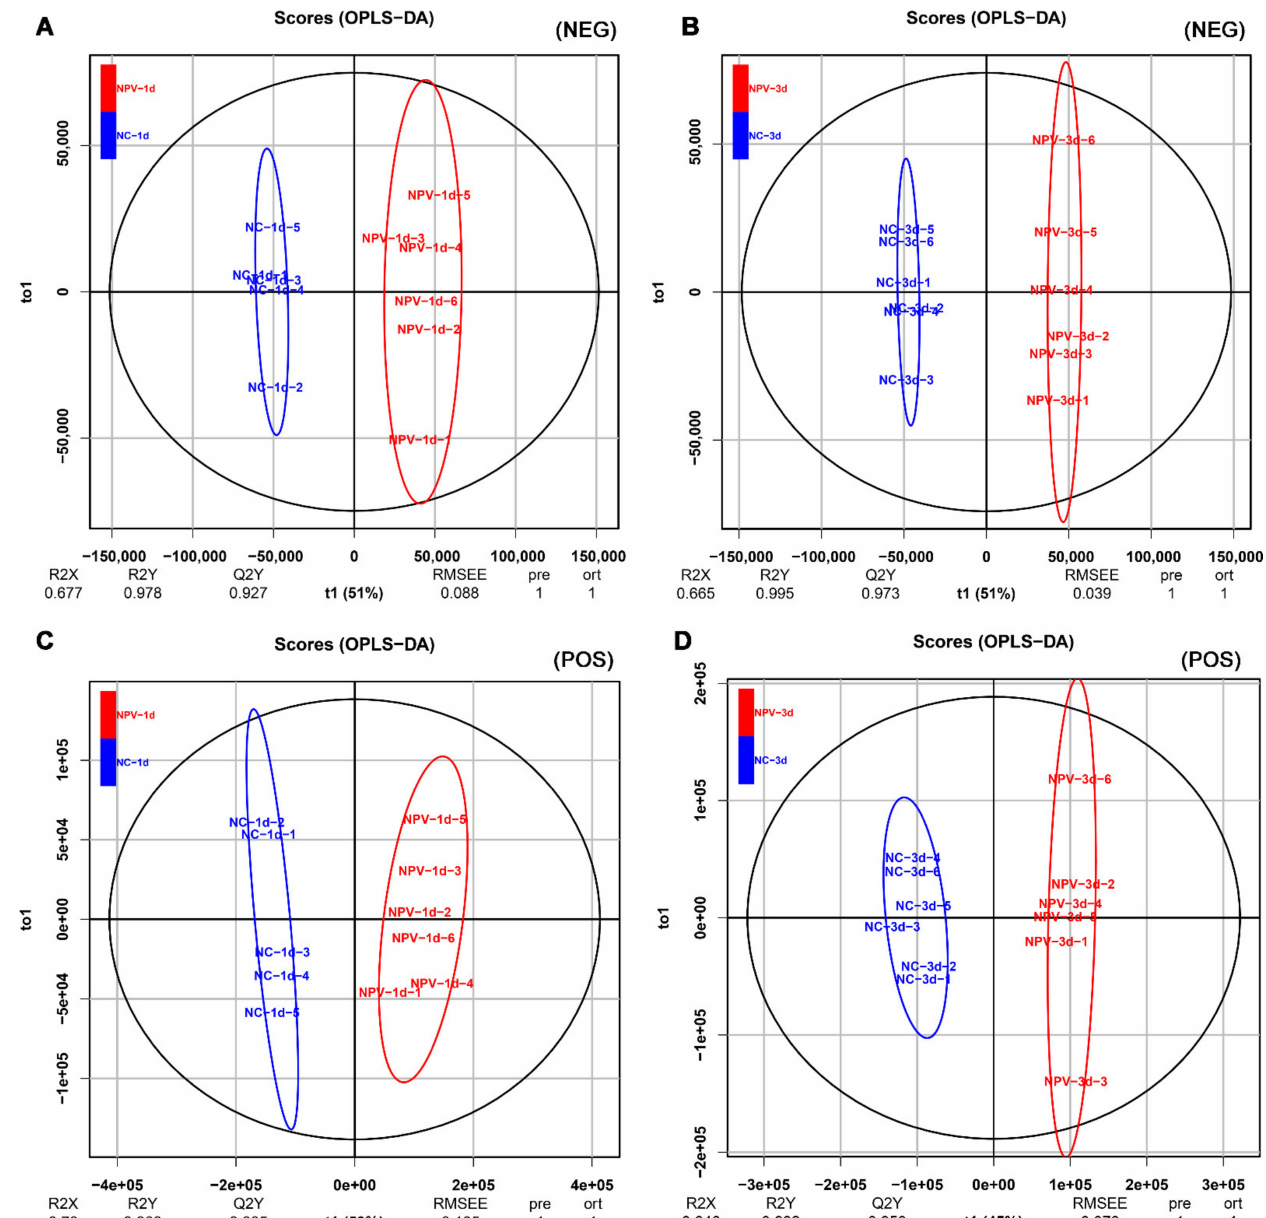
Figure 2. OPLS-DA scores of polar components of hemolymph metabolic profiling analysis. The OPLS-DA models (A, B, C, D) were derived from the LC-MS/MS metabolomic profiles of the hemolymph samples. Both negative mode (NEG) and positive (POS) models are shown for 1 dpi ( A , C ) and 3 dpi ( B , D ) as